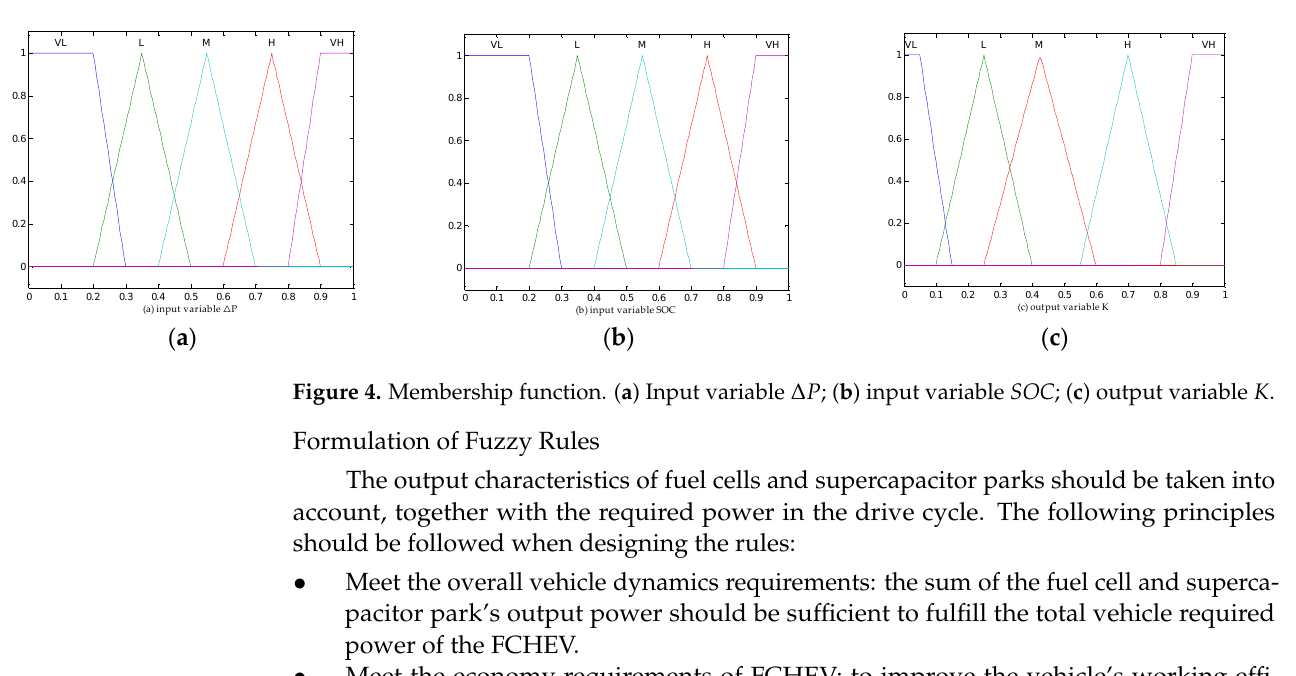
Figure 3. Compound energy management strategy. ( a ) Composition diagram; ( b ) simulation struc- ture diagram. structure diagram.